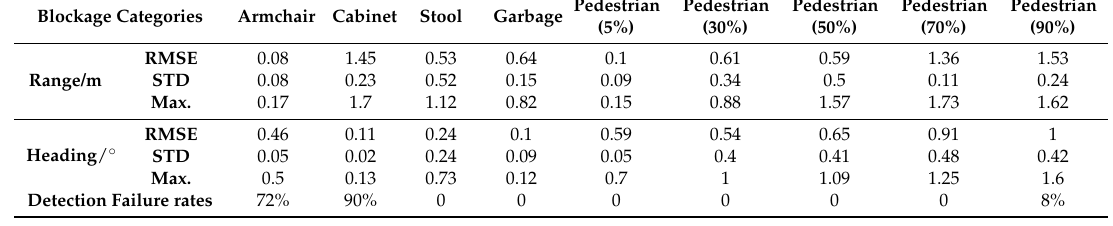
Table 2. The ranging and heading error and detection failure rates in obstacle environments. Blockage Categories